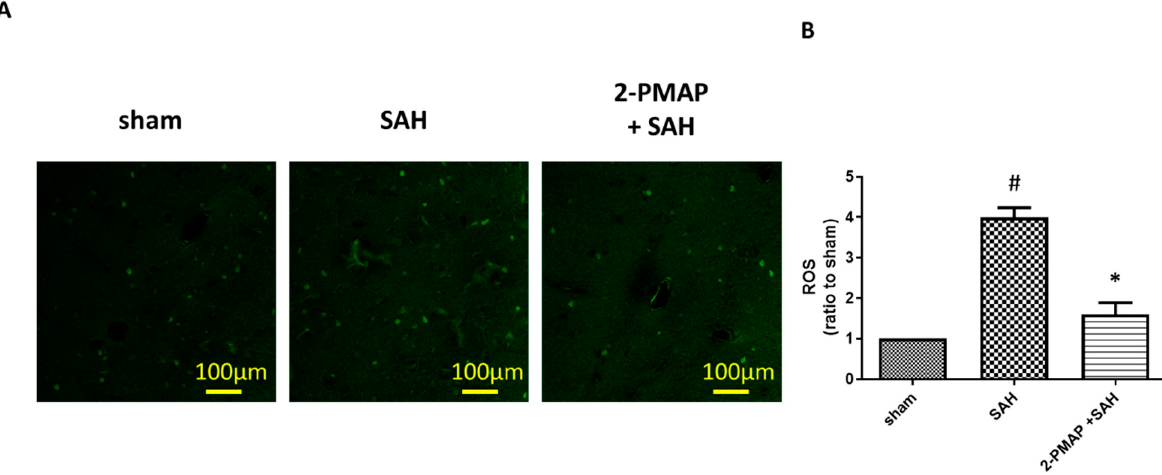
Figure 7. 2-PMAP decreased reactive oxygen synthase (ROS) in SAH rats. Slices of brain tissues were prepared in rats treated with the administration of 2-PMAP, or not, 48 h after the SAH. Immunoflu- orescence staining showing ROS elevated in brain tissues after SAH. ( A ) Representative images of ROS in the brain tissues. Scale bars: 100 µ m. ( B ) Relative fluorescence intensity of ROS. Data are shown as mean ± SD ( n = 6 for each group). *, p < 0.05, significantly different from the SAH group. #, p < 0.05, significantly different from the sham group.